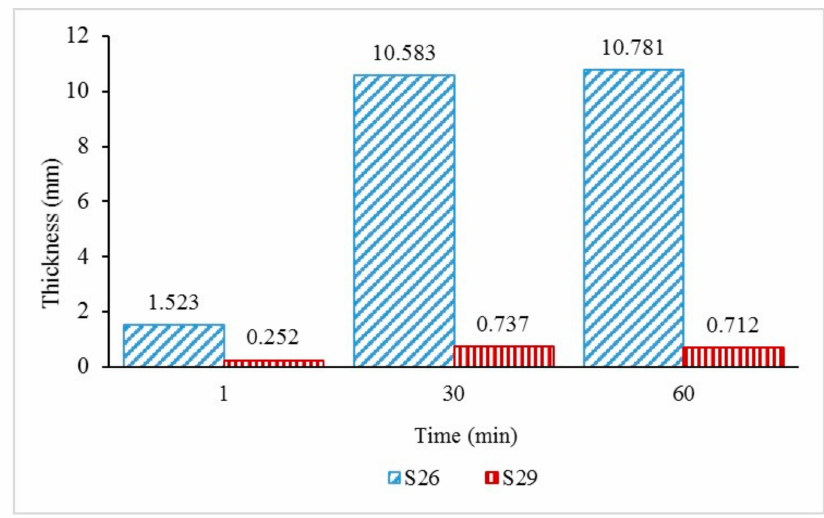
Figure 7. S26 and S29 char layer thickness with increasing time.